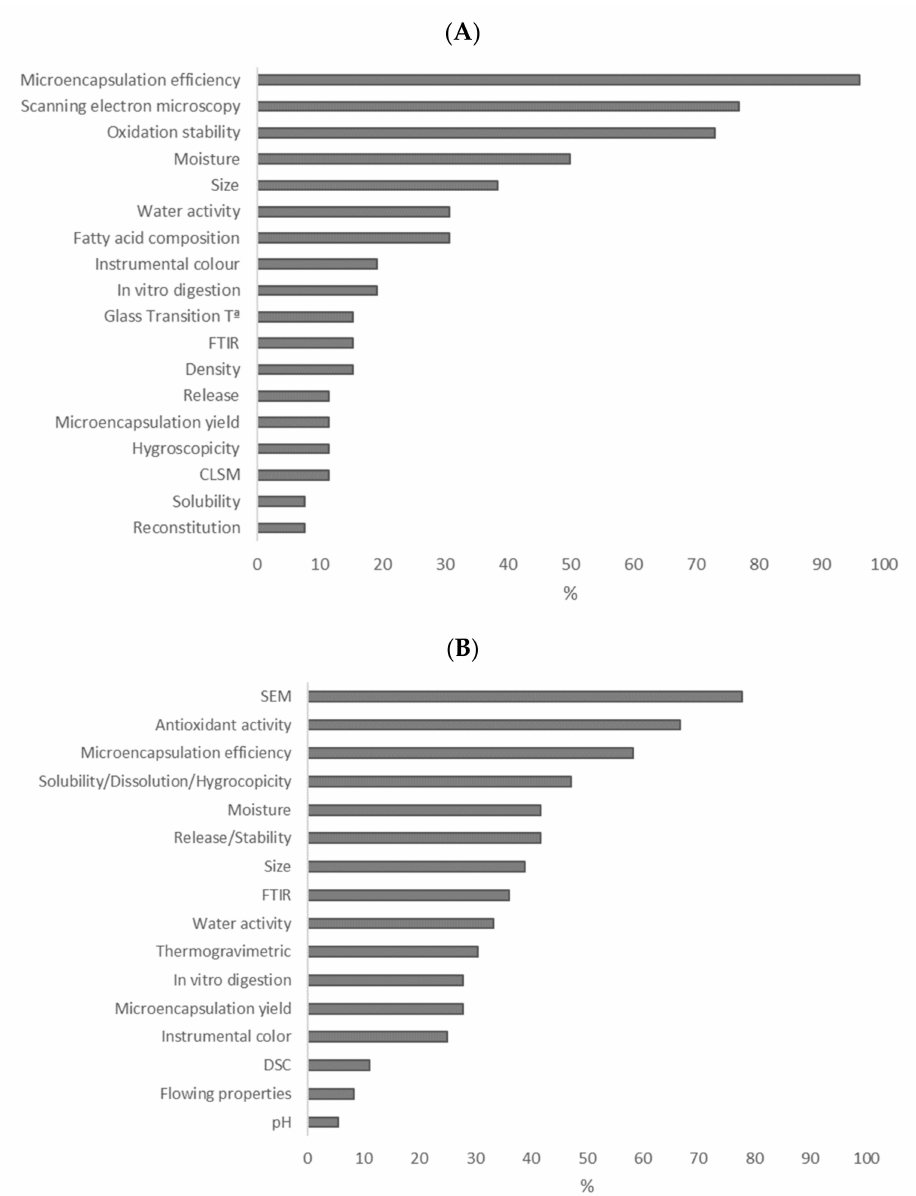
Figure 5. Extent of use of most applied analyses for the quality evaluation of fish oil microcapsules ( A ) and antioxidant microcapsules ( B ) in recent